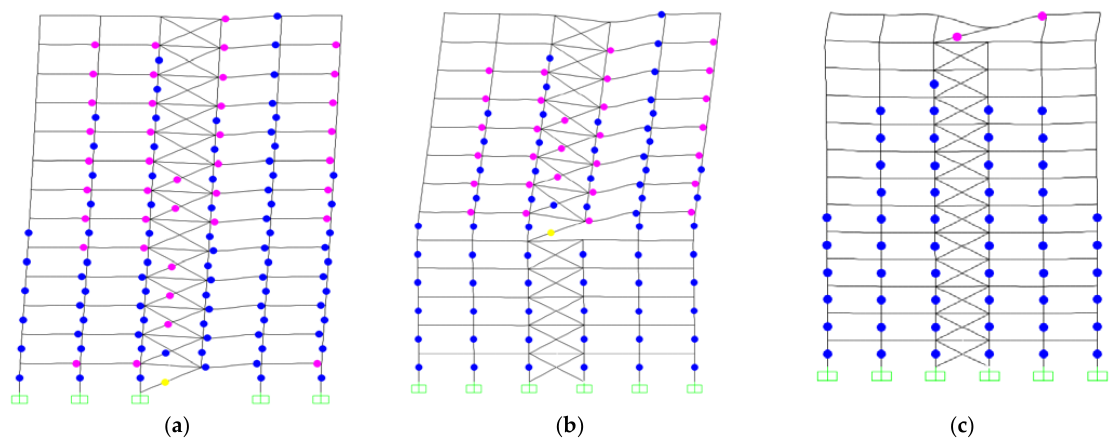
Figure 8. Hinge formation in the X braced frame exposed to column removal in ( a ) story one, ( b ) story six, and ( c ) story thirteen.